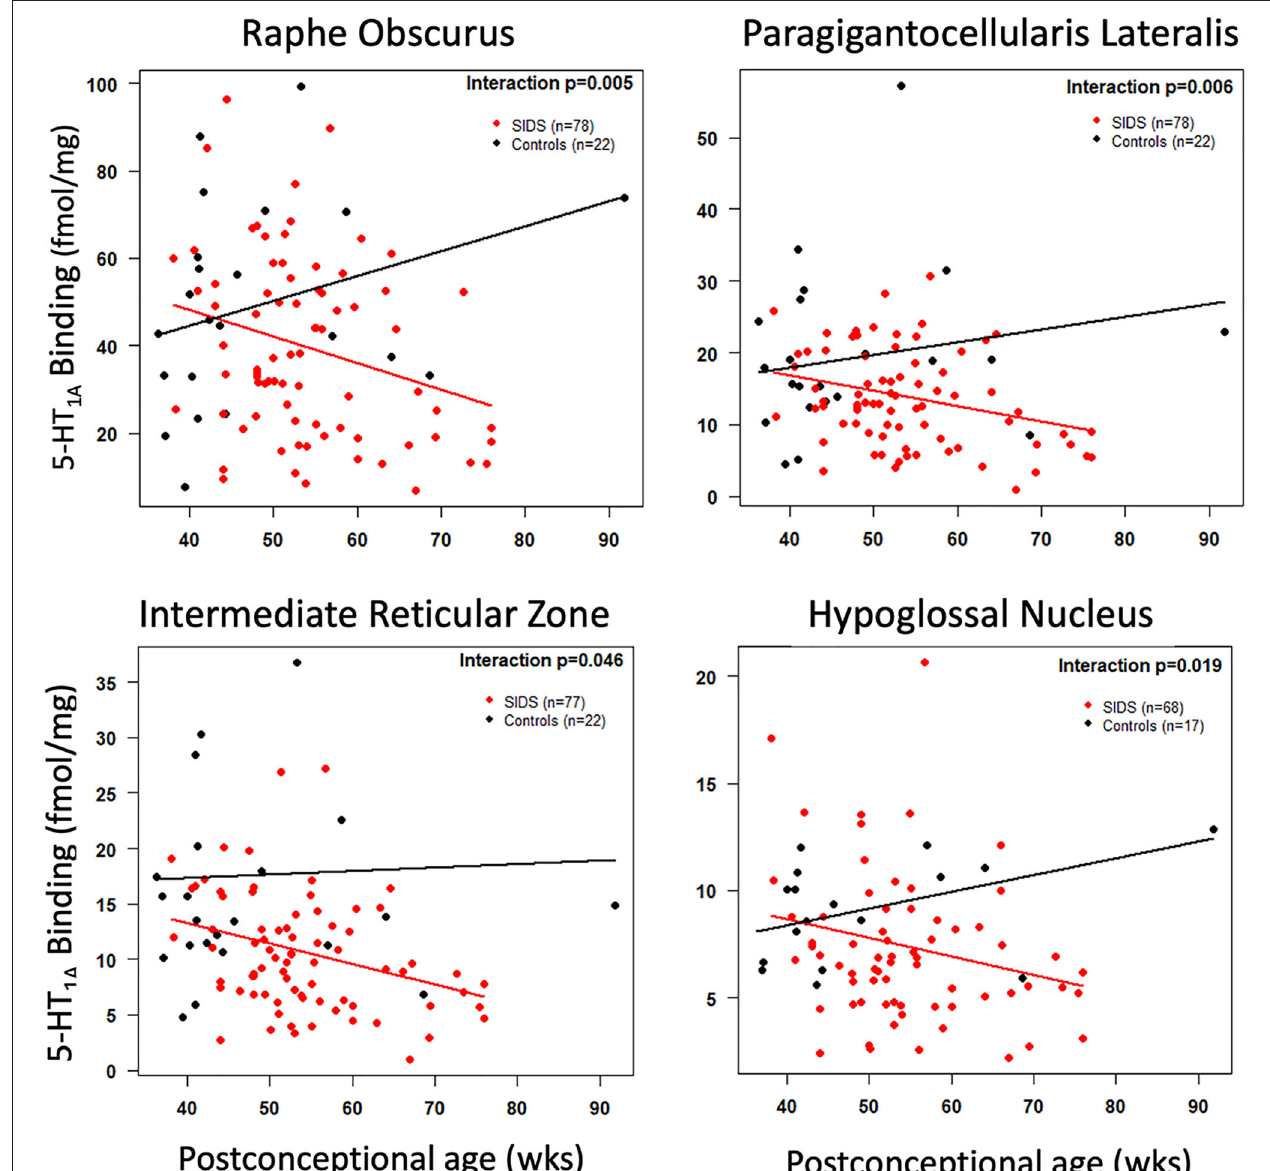
FIGURE 3 | Cross-sectional association of postconceptional age and medullary 5-HT 1A binding in selected nuclei. The red and black lines represent the estimated dataset-adjusted mean of 5-HT 1A binding according to postconceptional age for SIDS and controls from combined datasets, respectively. The p -value reflects a postconceptional age × Diagnosis